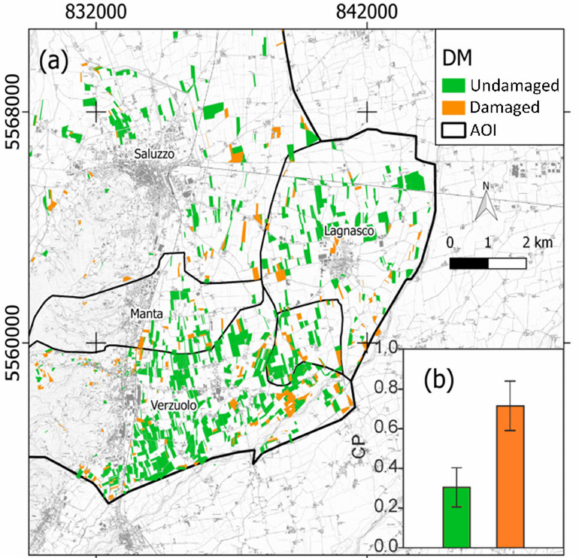
Figure 7. ( a ) DM binary classification of the OM in the AOI (reference frame is WGS84 UTM 32N); ( b ) bar chart representing mean and 1 SEM of the CP for DTFs and